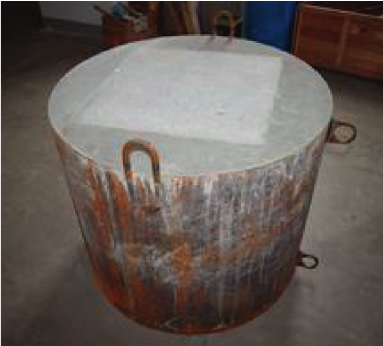
Figure 3: Photograph of targets.